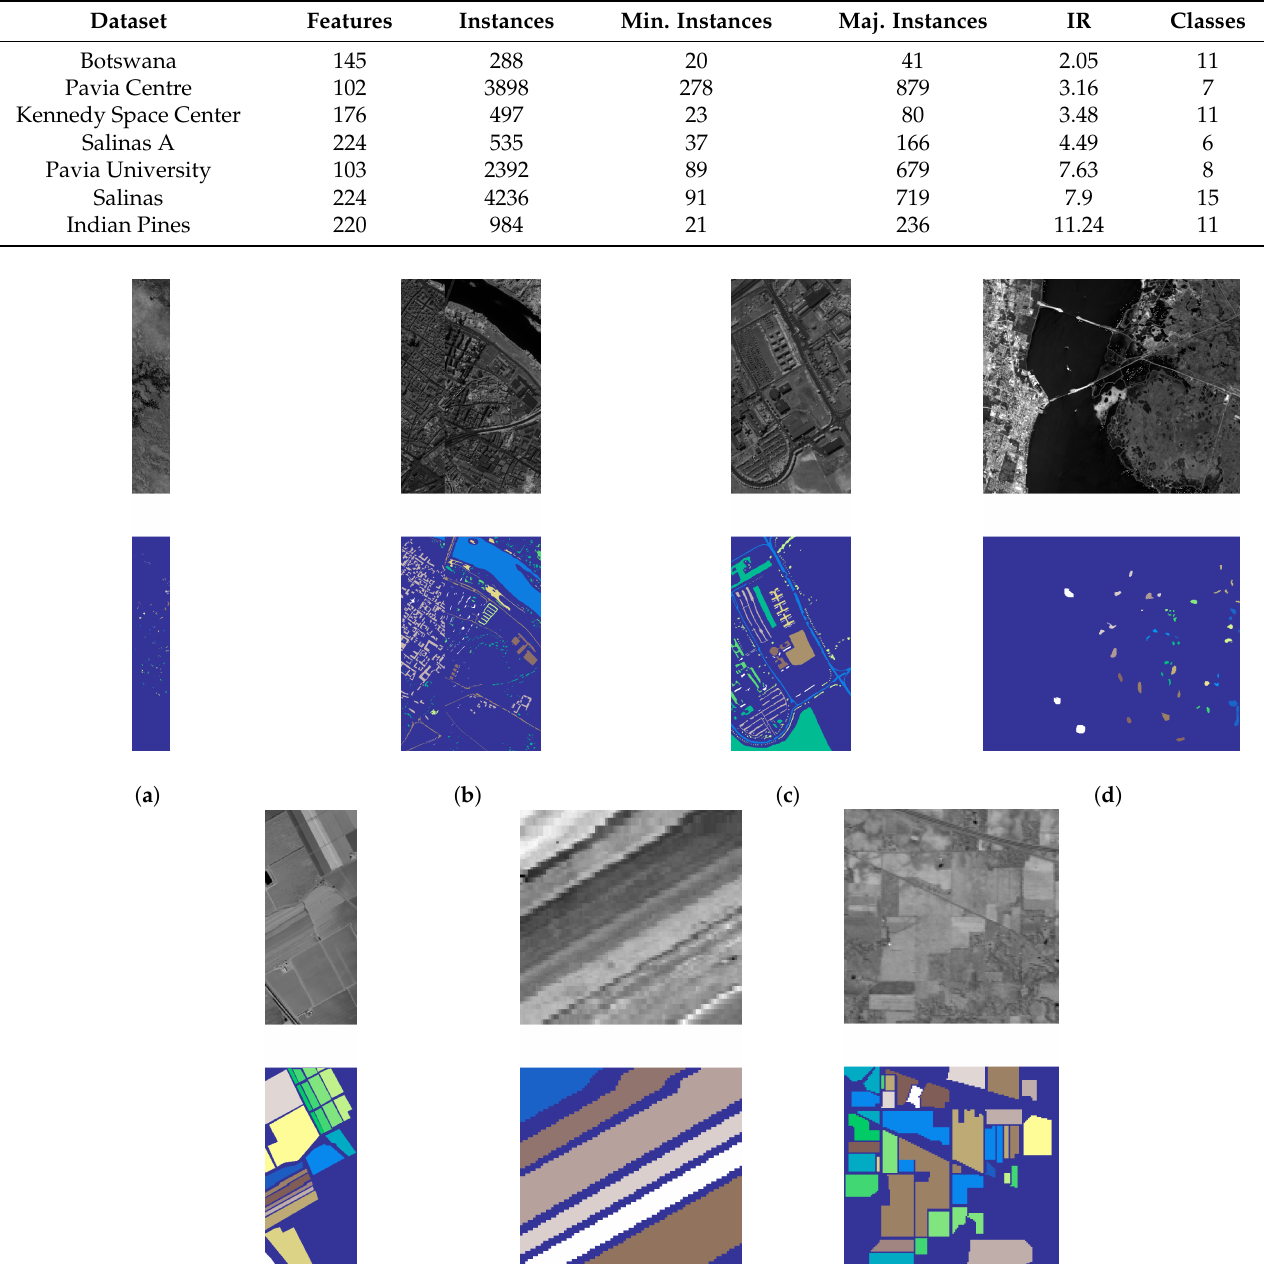
Table 1. Description of the datasets used for this experiment.